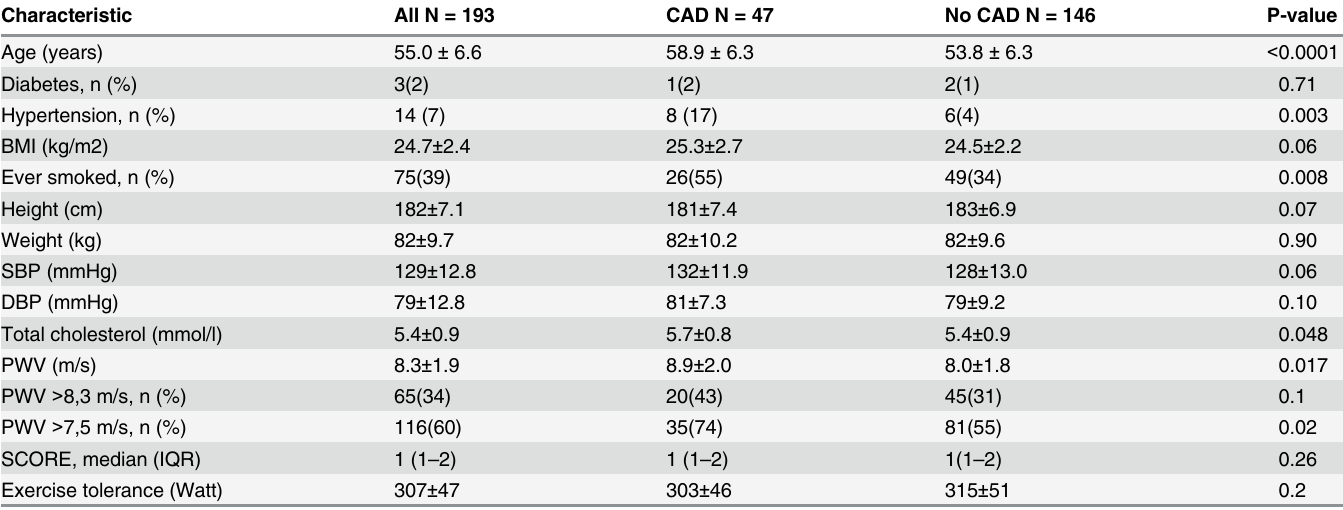
Table 1. Baseline